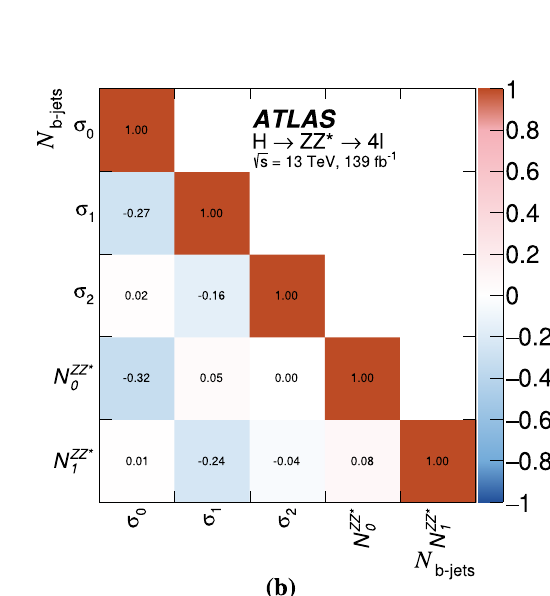
events with at least one b -tagged jet. The corresponding correlation matrices between the measured cross sections and the Z Z ∗ background normalisation factors are also shown in ( b